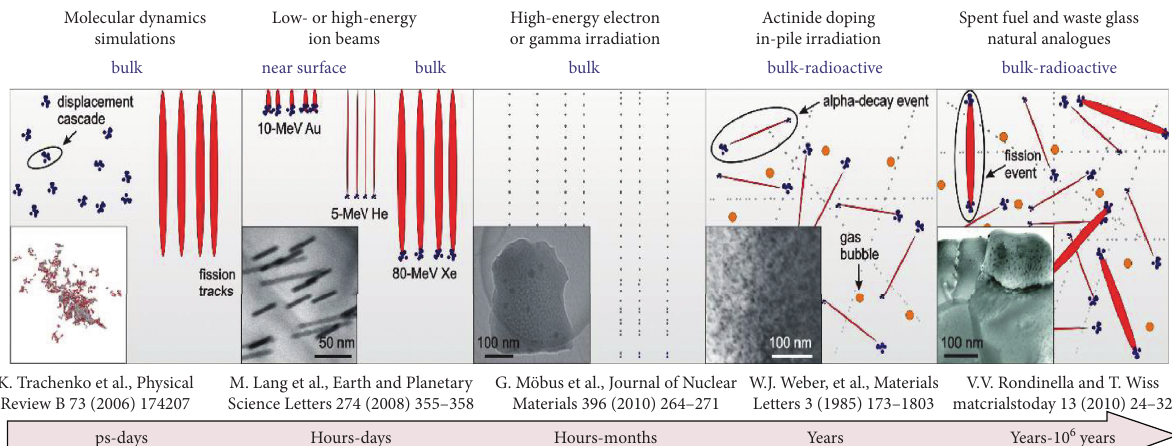
Figure 3: Methods to investigate radiation-induced ageing of nuclear materials. Courtesy: Maik Lang, University of Tennessee, US.